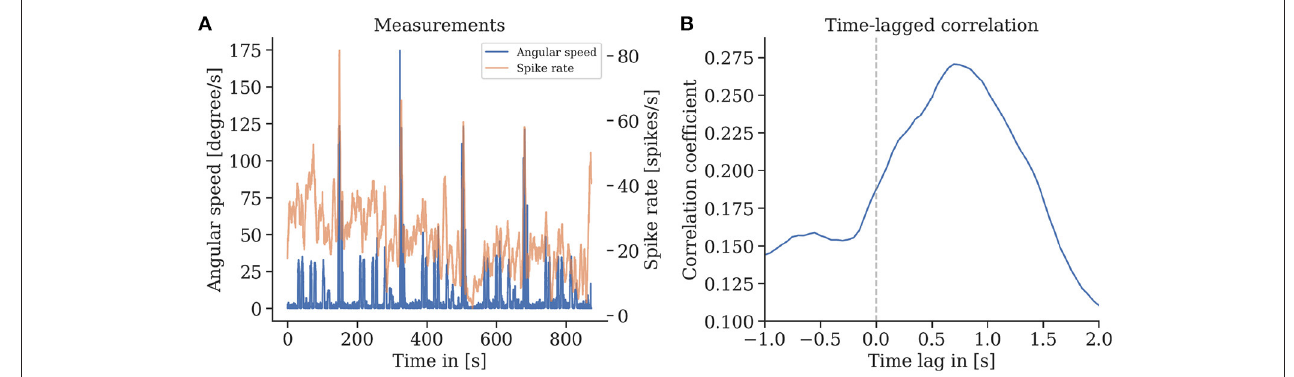
FIGURE 10 | (A) Spike rate of mushroom body output neurons of an individual bee and angular velocity during flight. (B) A strong time-lagged correlation between spike rate and rotational speed (yaw) was found with a lag of 0.7 s (Pearson’s r 0.27, p ≪ 0.001).